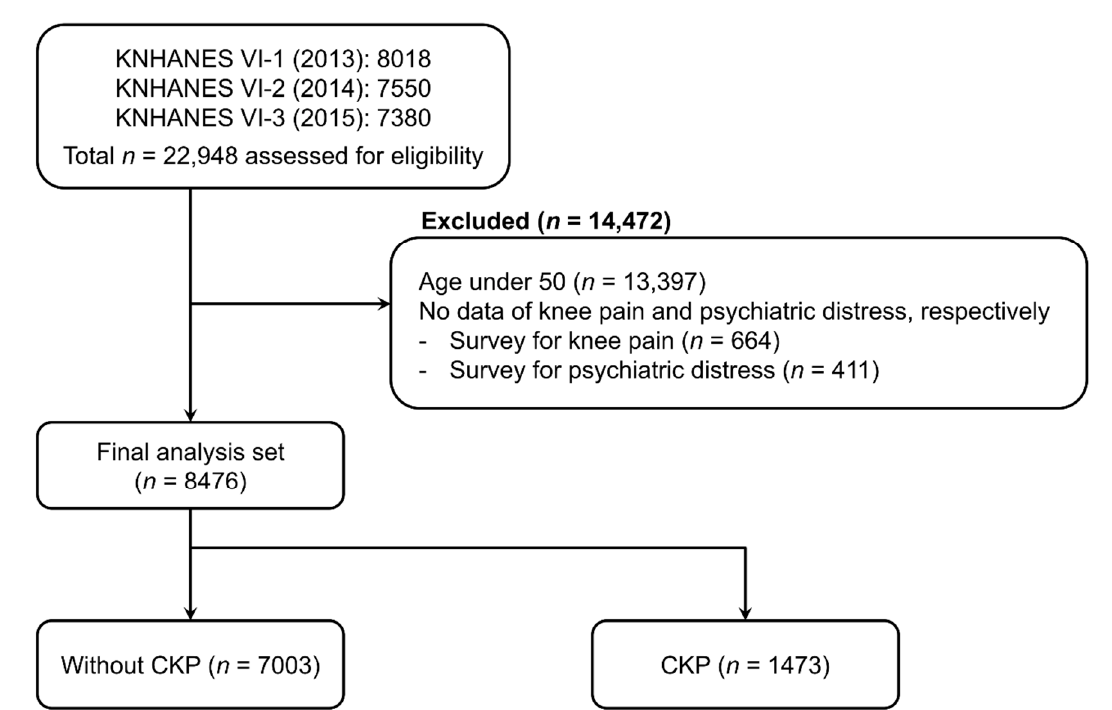
Figure 1. Flow chart of the study participants (Korea National Health and Nutrition Examination Survey [KNHANES], 2013–2015). Abbreviation: CKP, chronic knee pain. Table 1. General characteristics of the study subjects according to presence of